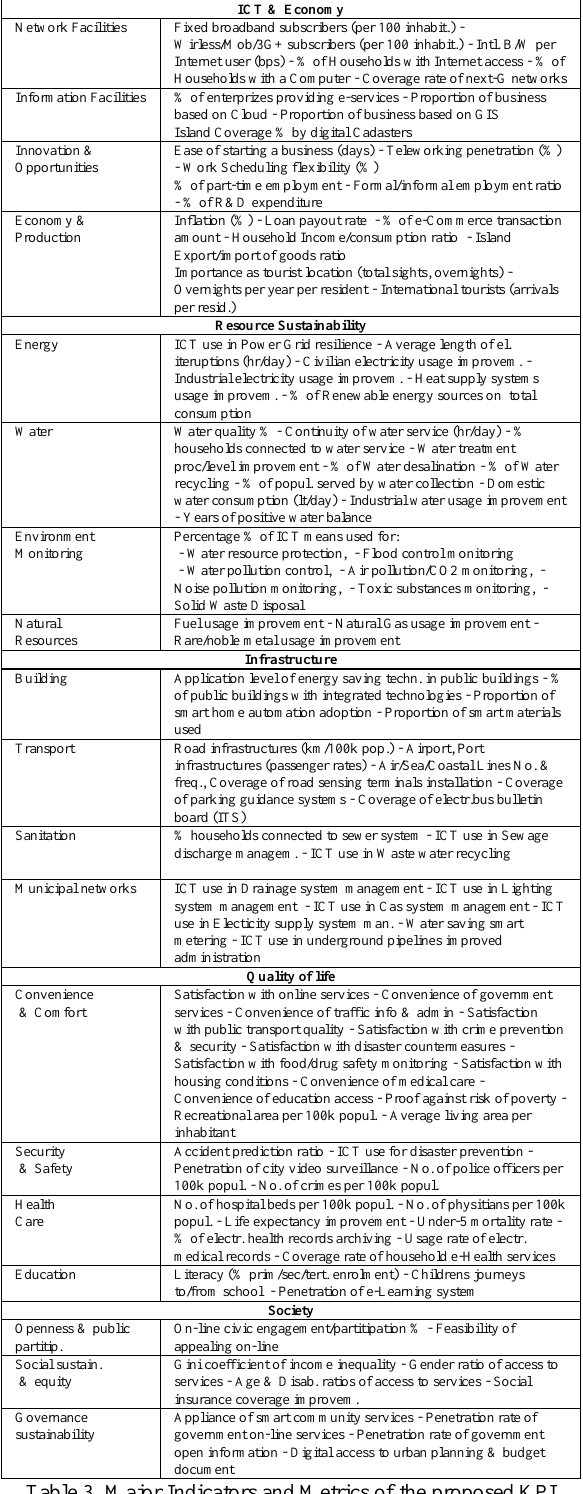
Table 3. Major Indicators and Metrics of the proposed KPI scheme for Smart Sustainable Islands Index (S 2 I 2